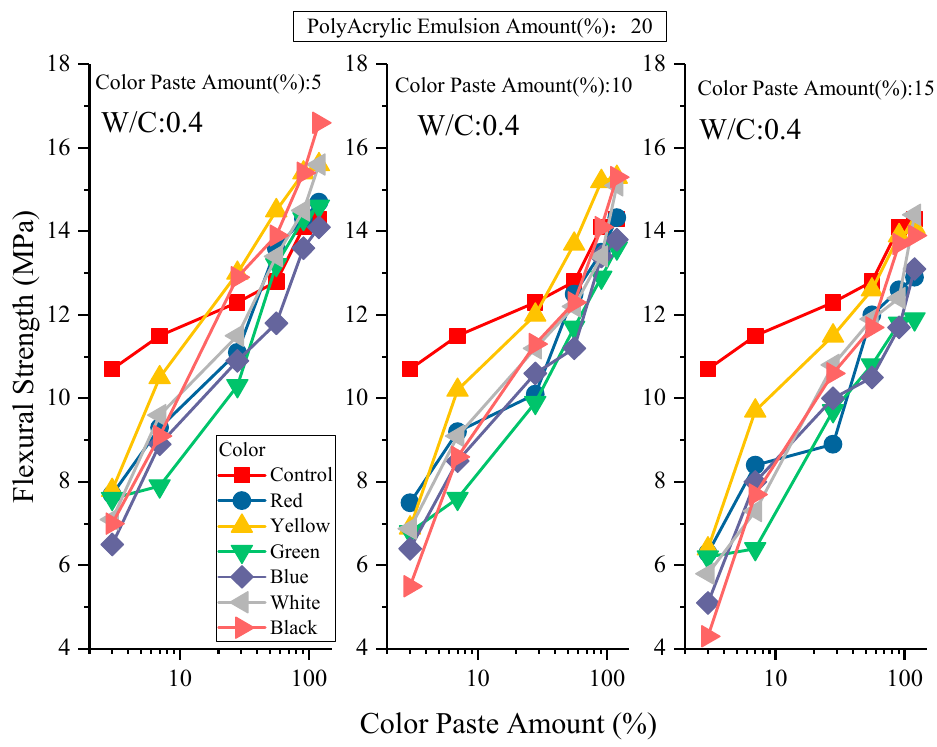
Figure 6. Flexural strength of mortar with different proportions of inorganic color paste.